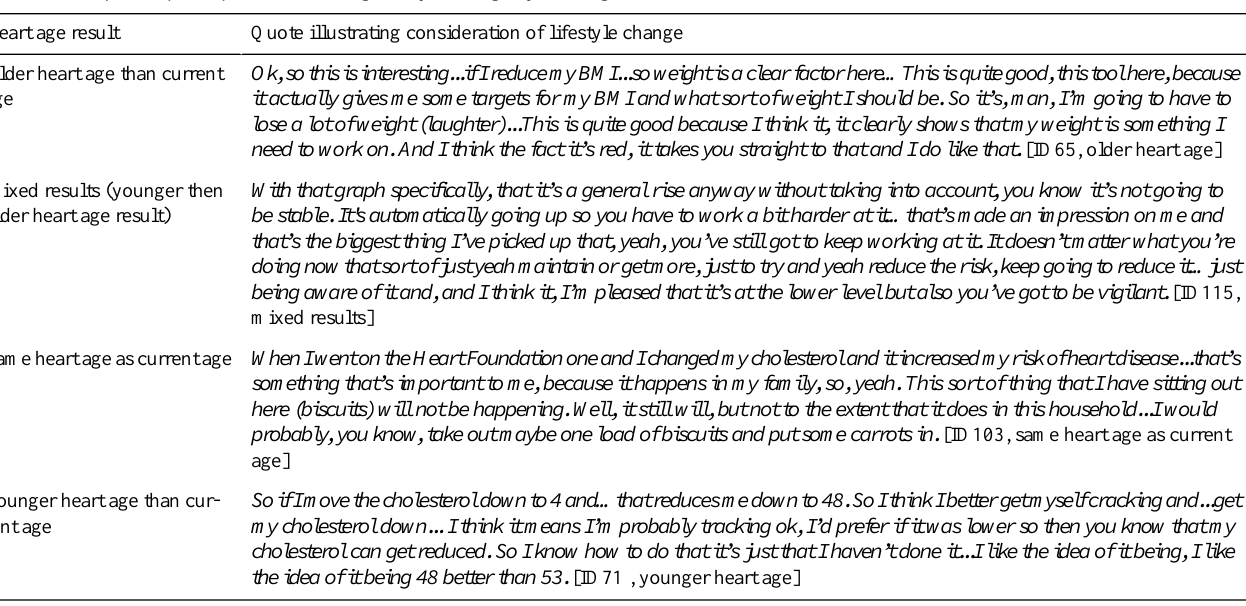
Table 4. Examples of participants considering lifestyle change by heart age result. Quote illustrating consideration of lifestyle changeHeart age